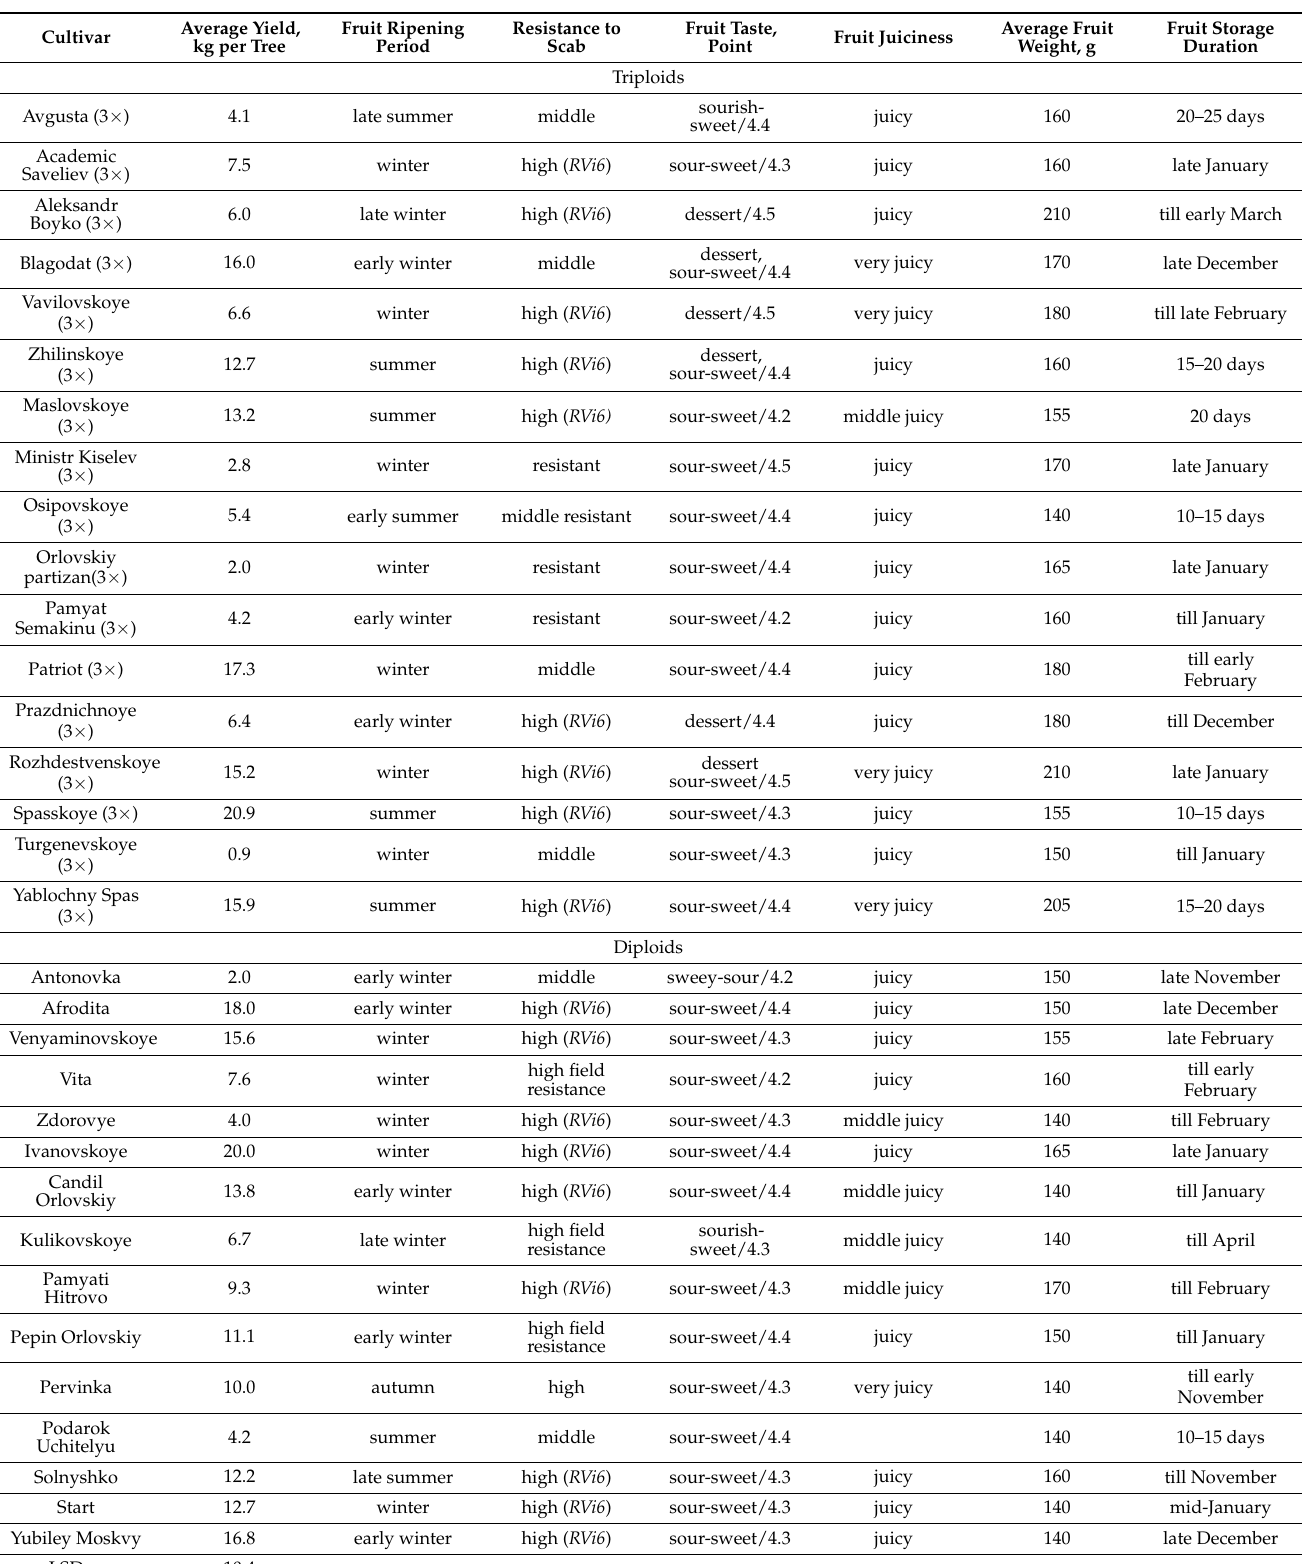
Table 2. Evaluation of apple cultivars by the main economic and biological indicators (2018–2021). Planting in autumn